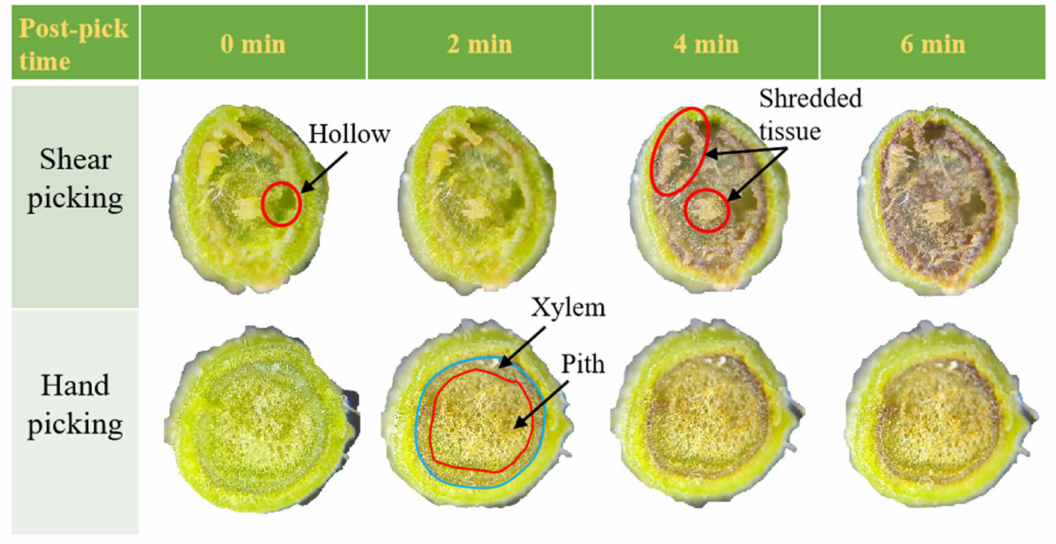
Figure 6. Appearance of the wound areas caused by hand and shear-blade picking of tea